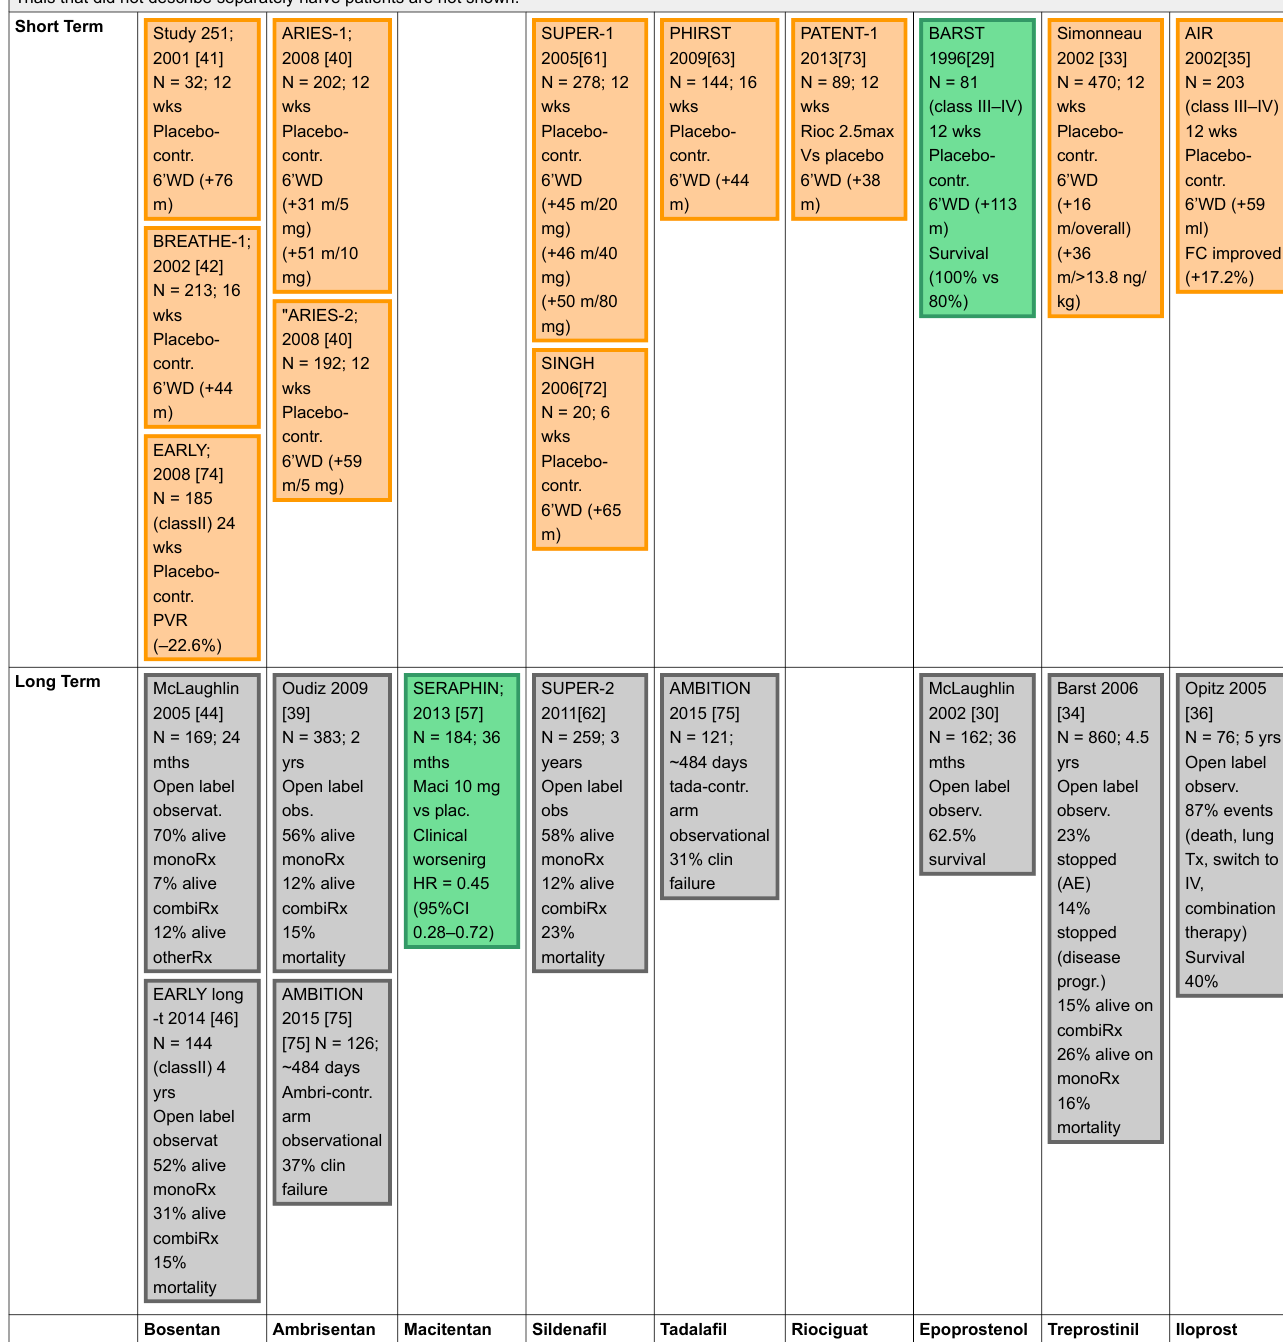
Table 1: Trials investigating monotherapy in PAH. Only numbers (N) from naïve patients are reported while data from patients on background therapy have been omitted. Trials that did not describe separately naïve patients are not shown. Short